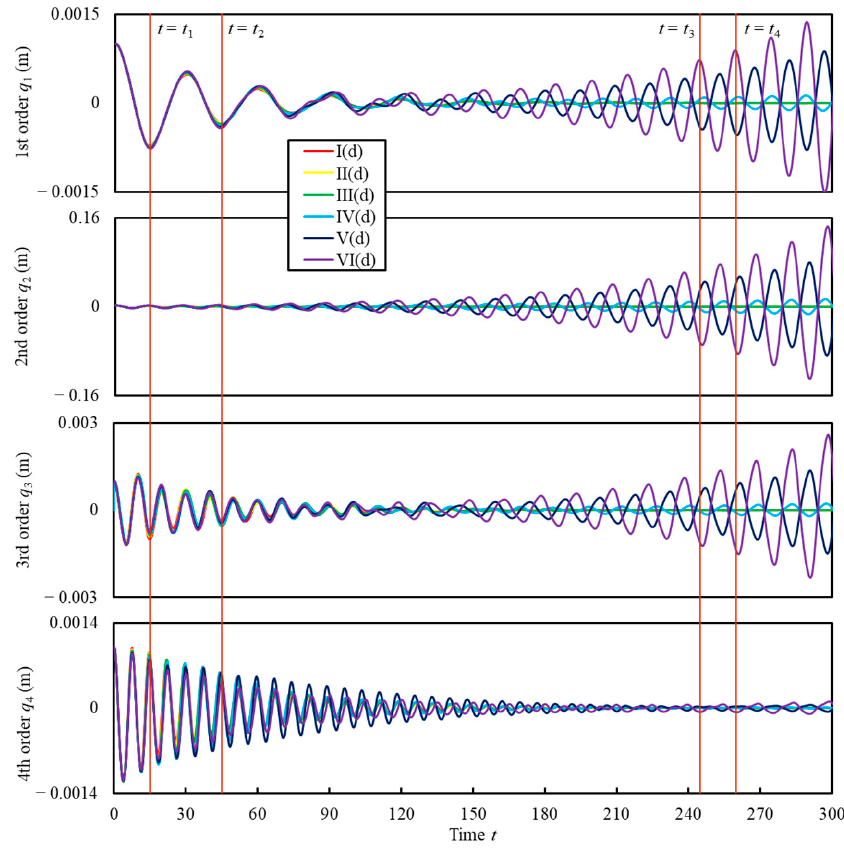
Figure 13. The responses of the first 4 modes of cases with different excitation periods.